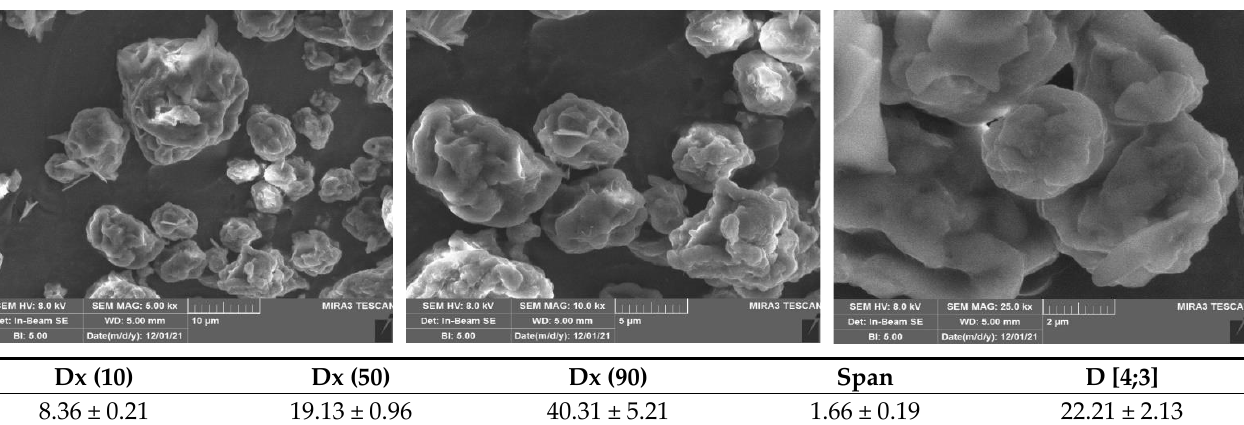
Figure 1. SEM micrographs ( top part ) and particle size parameters ( bottom part ) of SD crickets. The Shapiro-Wilk tests did not show a significance departure from the normality ( p < 0.05).